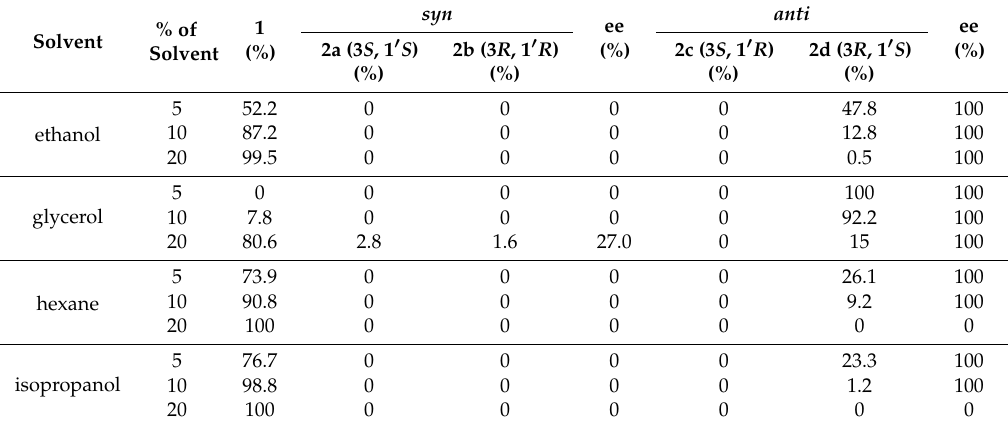
Table 7. The results of biotransformation of α -acetylbutyrolactone 1 by R. marina AM77 in mixtures of Medium A and different solvents in different proportions (in % according to GC (chiral column)) after 2